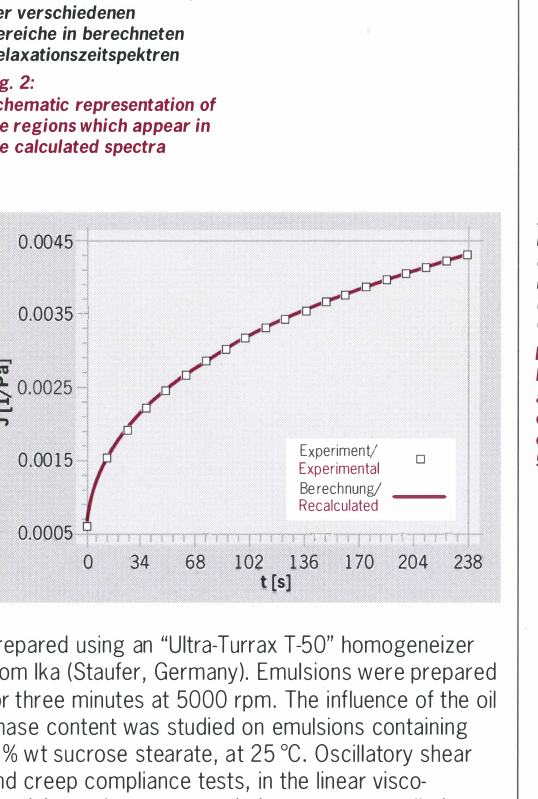
Fig. 2: Schematic representation of the regions which appear in the calculated spectra